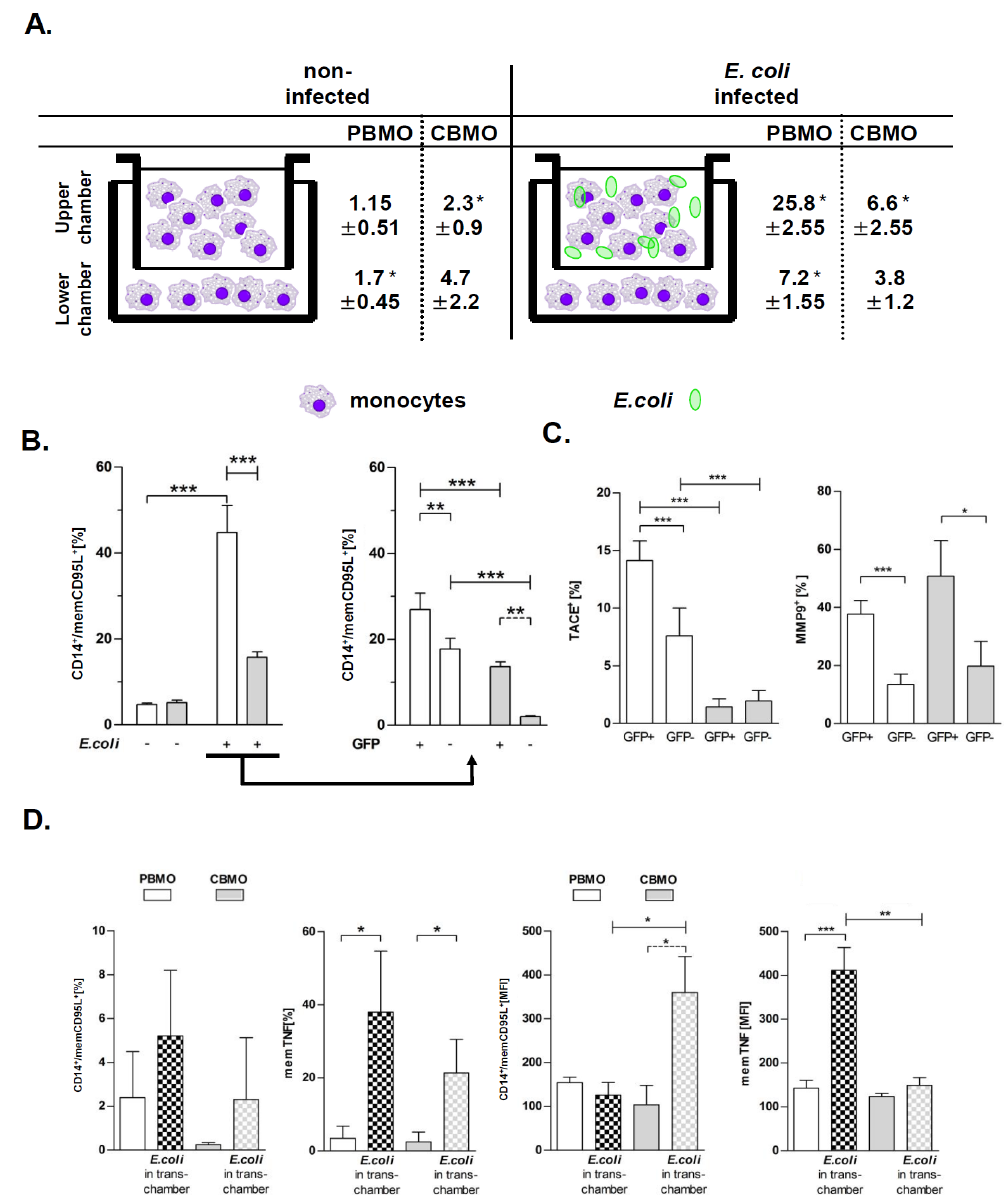
Figure 5. Monocyte PICD is enhanced by cell–cell contact. Monocytes were infected with GFP- E. coli for one hour, washed and re-incubated for another 24 h in transwell chambers (experimental setup sketch); non-infected cells served as controls. Monocytes from the same donor were co-cultivated in compartments, separated by teflon membranes. Apoptosis was detected by hypodiploid DNA-content ( A , n = 6 for PBMO and n = 4 for CBMO; * p < 0.05). PBMO and CBMO were sub-gated ( B ) in phagocyting/binding (GFP + ) and non-phagocyting (GFP − ) monocytes and analyzed for memCD95L expression. Subgated PBMO and CBMO were further analyzed for TACE ( C , left panel) and MMP9 ( C , right panel) expression. ( D ) The expression of memCD95L and memTNF of monocytes in the lower (“trans“) chamber was assessed. The percentage of surface expressing monocytes (panels to the left) and the mean values (MFI, panels to the right) were determined ( n = 5, * p < 0.05, ** p < 0.01, *** p < 0.001, forked bars represent Student’s t -test, blunt-ended bars represent ANOVA).